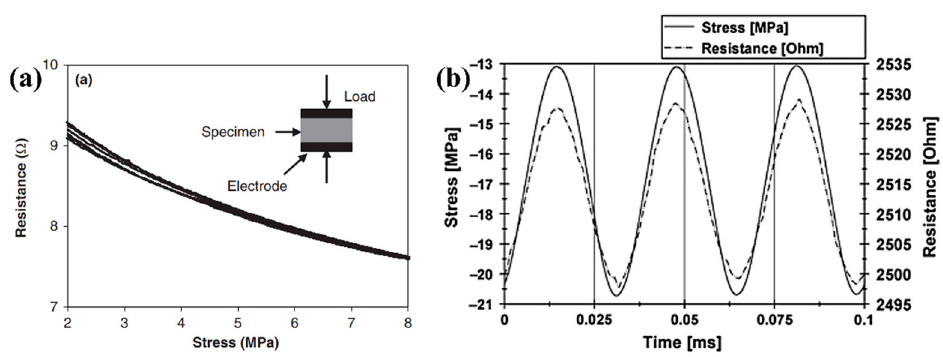
Figure 4. Experimental data of piezoresistivity response of ( a ) SiCN [53] and ( b ) SiCO